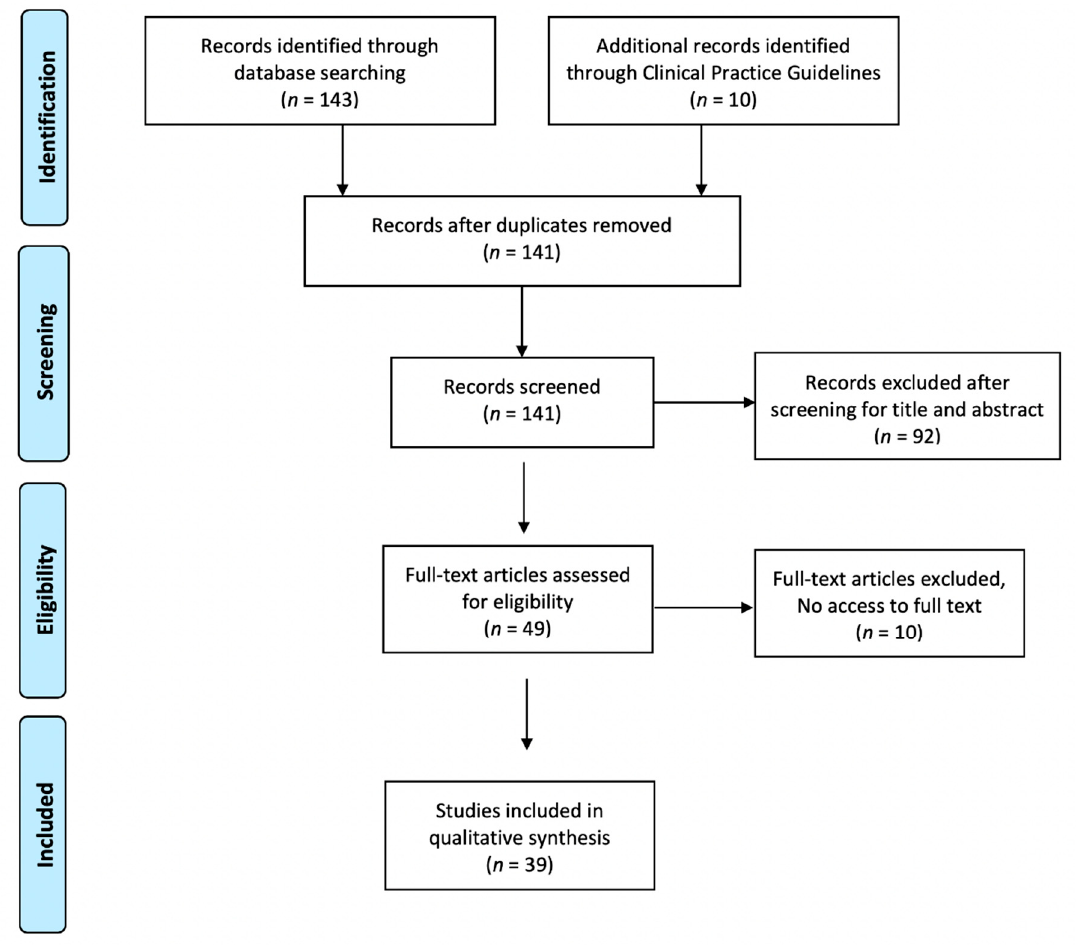
Figure 1. Flow diagram showing studies identified and selected.